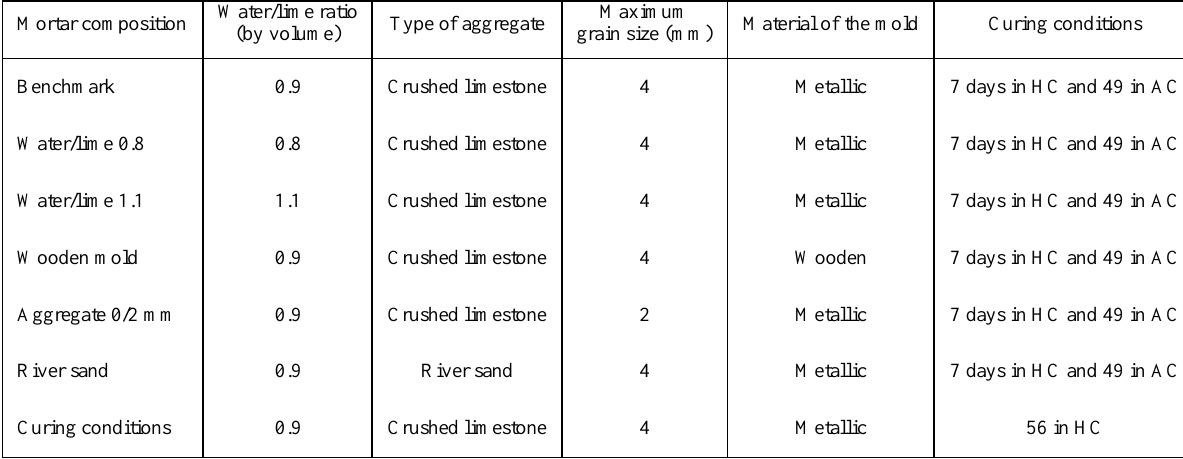
Table 1. Characteristics of the seven mortar compositions.